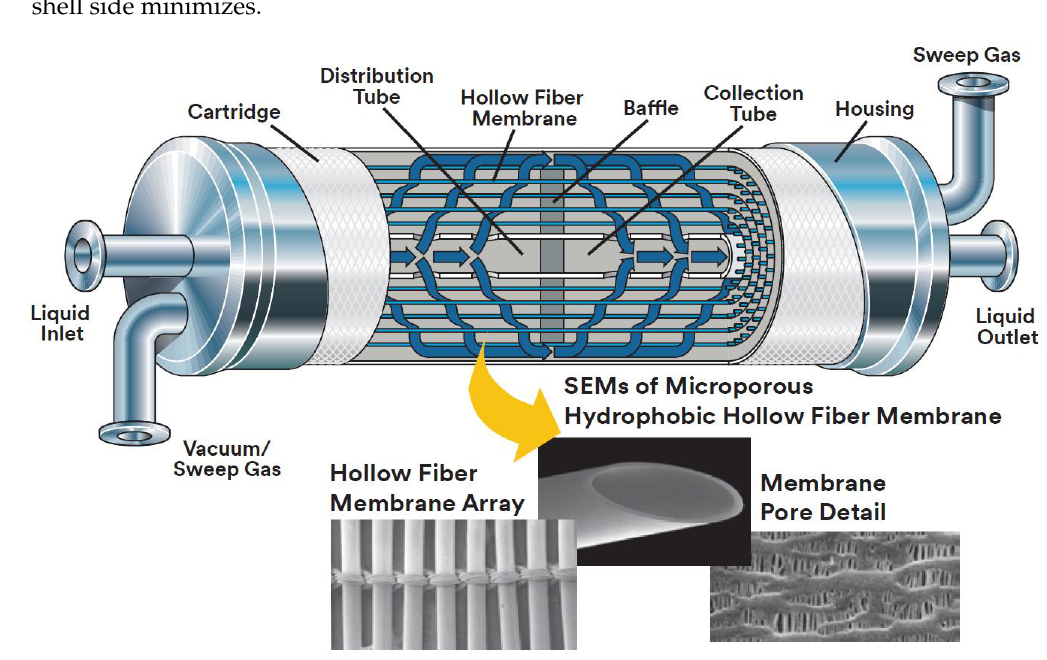
Figure 5. Module design and polypropylene hollow fibers in typical Liqui-Cel ® membrane contactor (adapted with permission from [37], Liqui-Cel™, 2017 3M Company).